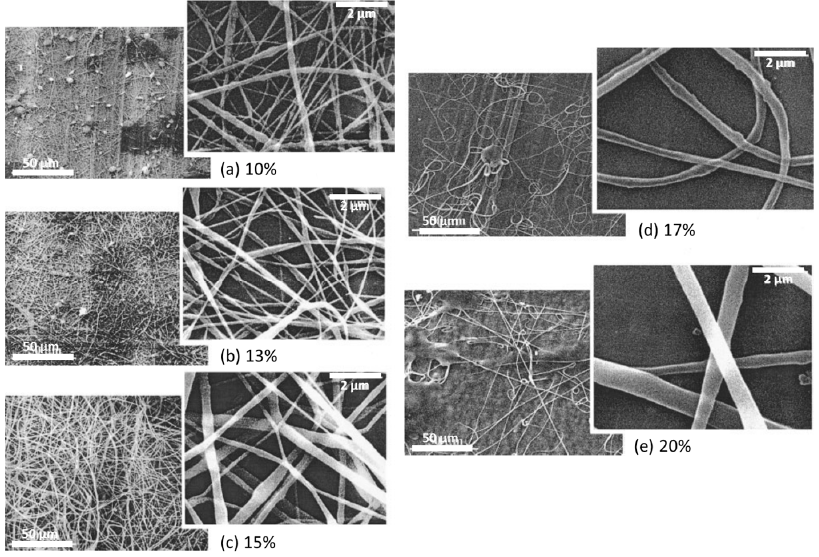
Figure 4. Variation of electrospun membrane morphology with polymer concentration. Original magnification: 500× (left) and 10 k× (right). Voltage: 5 kV; flow rate: 0.3 mL/h; distance: 10 cm; DMF/acetone = 8/2. ( a ) 10%, ( b ) 13%, ( c ) 15%, ( d ) 17%, ( e ) 20% Reprinted with permission from [67].